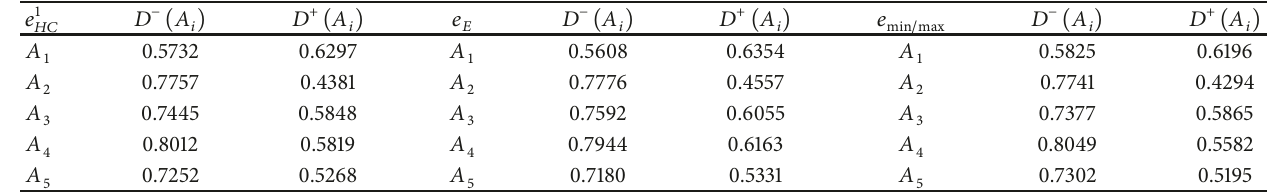
Table 14: Distance for each alternative.